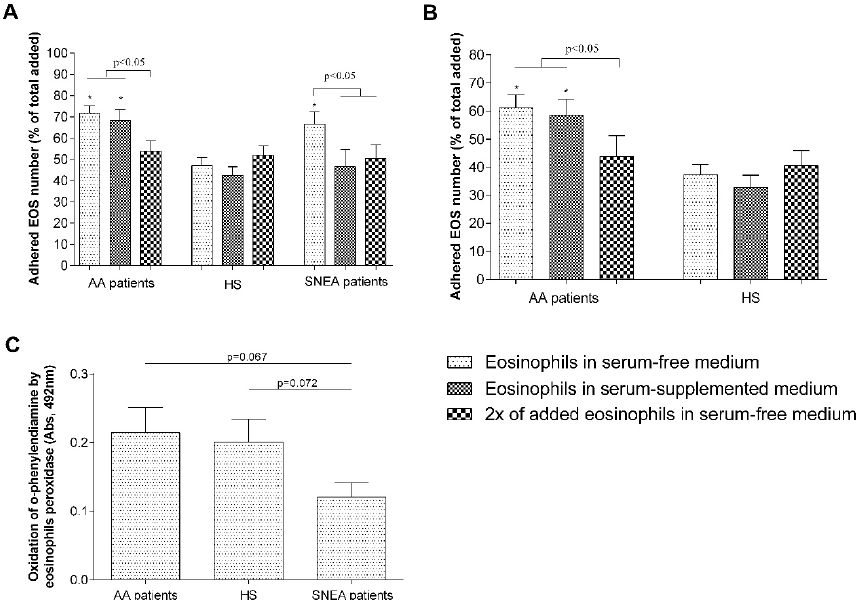
Figure 4. The efficiency of eosinophil adhesion. ( A ) Eosinophil adhesion in co-culture with airway